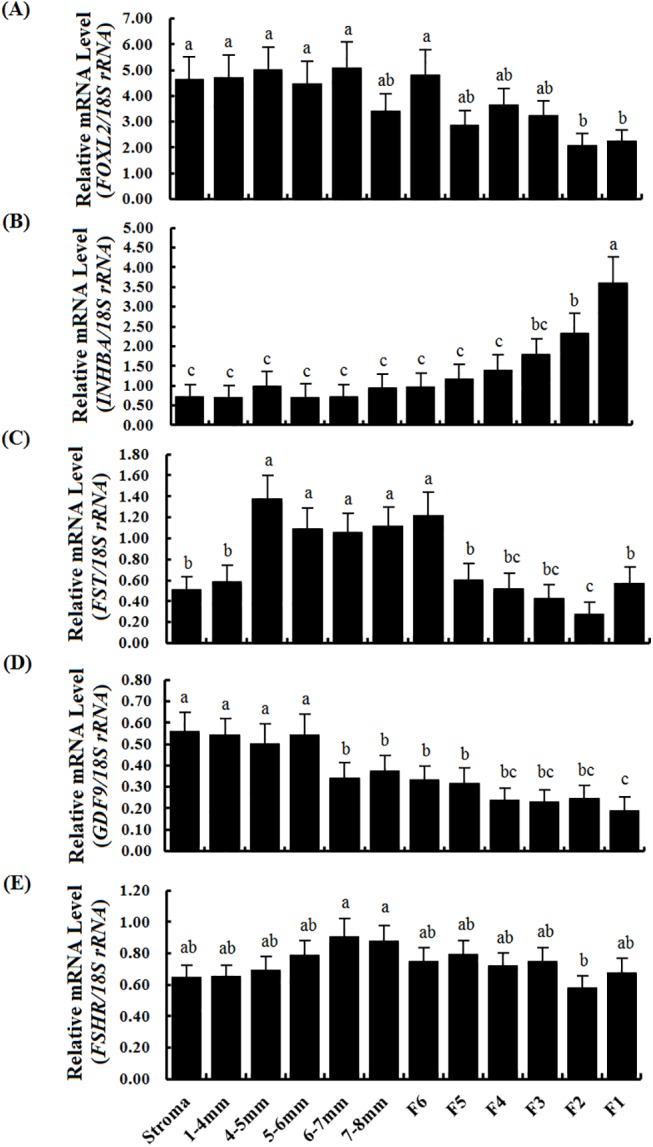
Quantification of mRNA expression levels of the FOXL2 gene in variously sized follicles form freshly collected ovaries.The data are the mean ± SEM from 10 hens (n = 10), and bars with different letters above them differ significantly in the amount of mRNA expression as normalized to the 18S rRNA gene (P < 0.05). The ovarian stroma contains matrix tissue from large follicles (≥1 mm in diameter), small follicles (<1 mm in diameter), atretic follicles, somatic and other cells. 1–4 mm, the follicles were from 1 to 4 mm in diameter; 4–5 mm, >4 mm but ≤5 mm in diameter; 5–6 mm, >5 mm but ≤ 6 mm in diameter; and the others followed similarly. (A) Quantification of FOXL2 mRNA levels by RT-qPCR. (B) Levels of INHBA mRNA. (C) Levels of FST mRNA. (D) Levels of GDF9 mRNA. (E) Levels of FSHR mRNA. Horizontal ordinate represents the examined follicle sizes as indicated in (E).